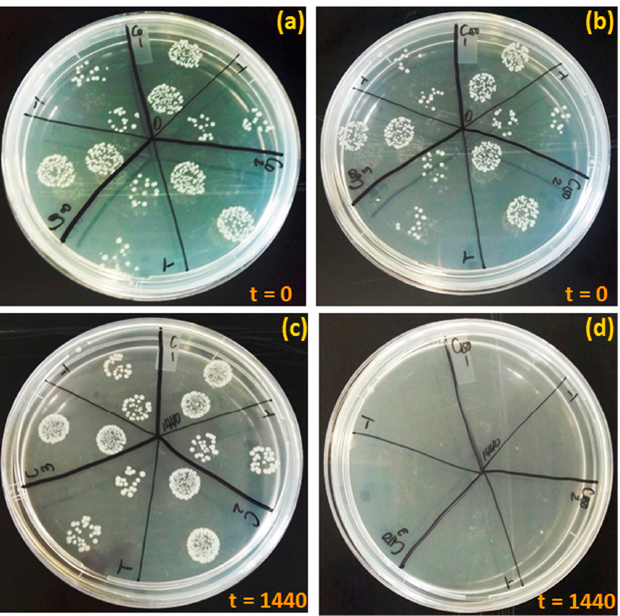
Figure 10. Pictorial diagram displaying the regrowth tests performed after exposure of E. coli to TFSA controls at ( a ) t = 0 and ( c ) t = 1440; regrowth tests performed after E. coli exposure to Cu@TFSA at ( b ) t = 0 and ( d ) t = 1440.